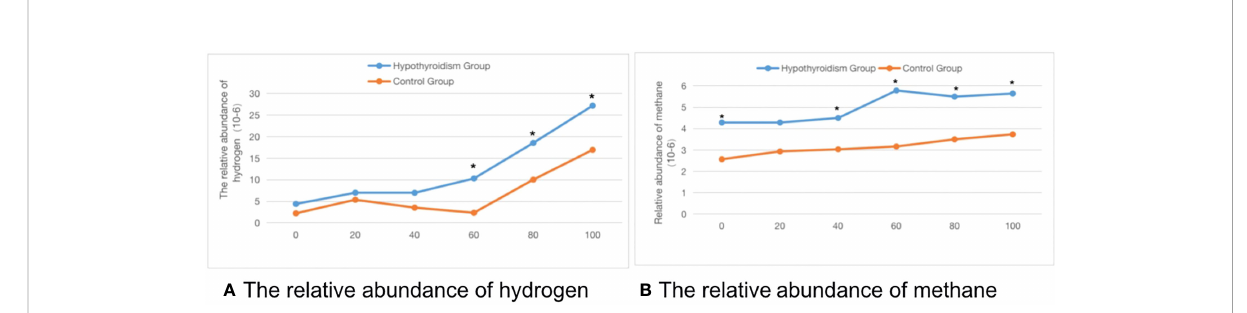
FIGURE 1 The time-abundance curve of hydrogen and methane in the control group and pregnant clinical hypothyroidism group. (A) The relative abundance of hydrogen. (B) The relative abundance of methane. *indicates statistical signi fi